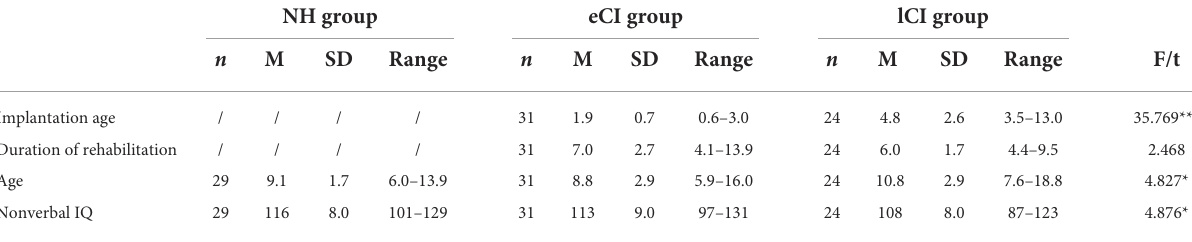
TABLE 1 Demographical data for children with early cochlear implant (eCI), children with late cochlear implant (lCI) and children with normal hearing